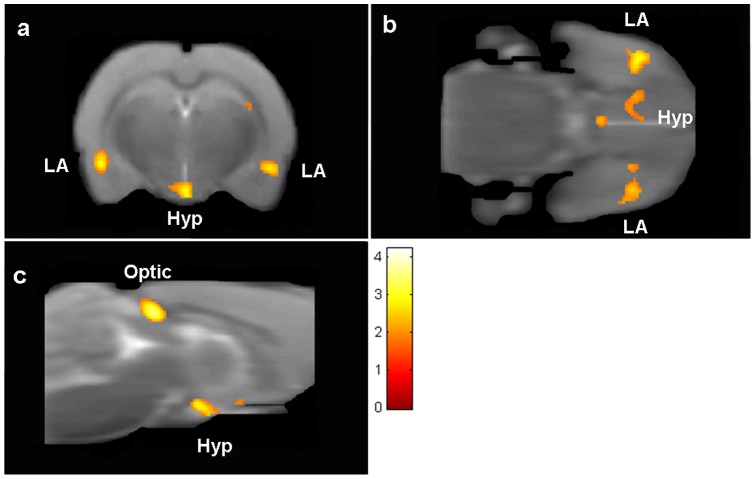
Consequence of early life stress on fear associated brain activation.Greater activation in response to CS presentation is observed in right and left lateral amygdalae (LA), hypothalamus (Hyp) and optic grey (optic) when ELS is compared to CON. (a) Coronal, (b) axial and (c) sagittal sections of rat brain. Control, n = 14; ELS, n = 8.